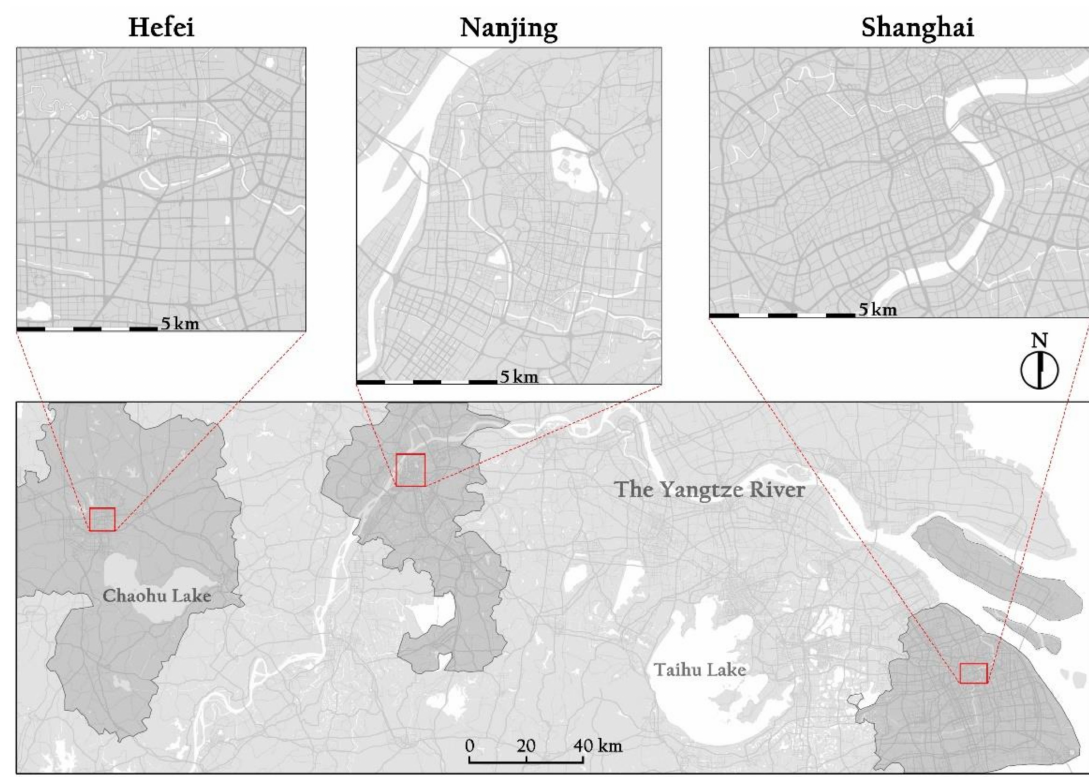
Figure 7. The study areas of the three metropolises (Shanghai, Nanjing and Hefei) in the Yangtze River Delta.